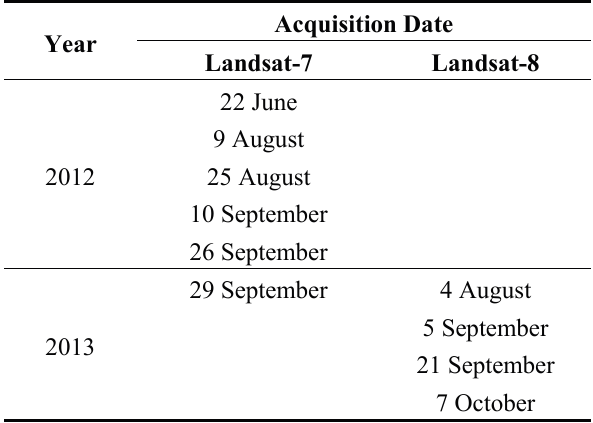
Table 1. Landsat image acquisitions used in this